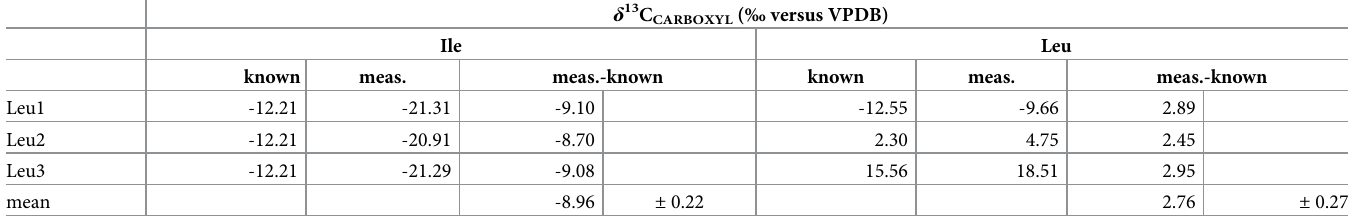
Table 4. Illustration of the Ile/Leu deconvolution